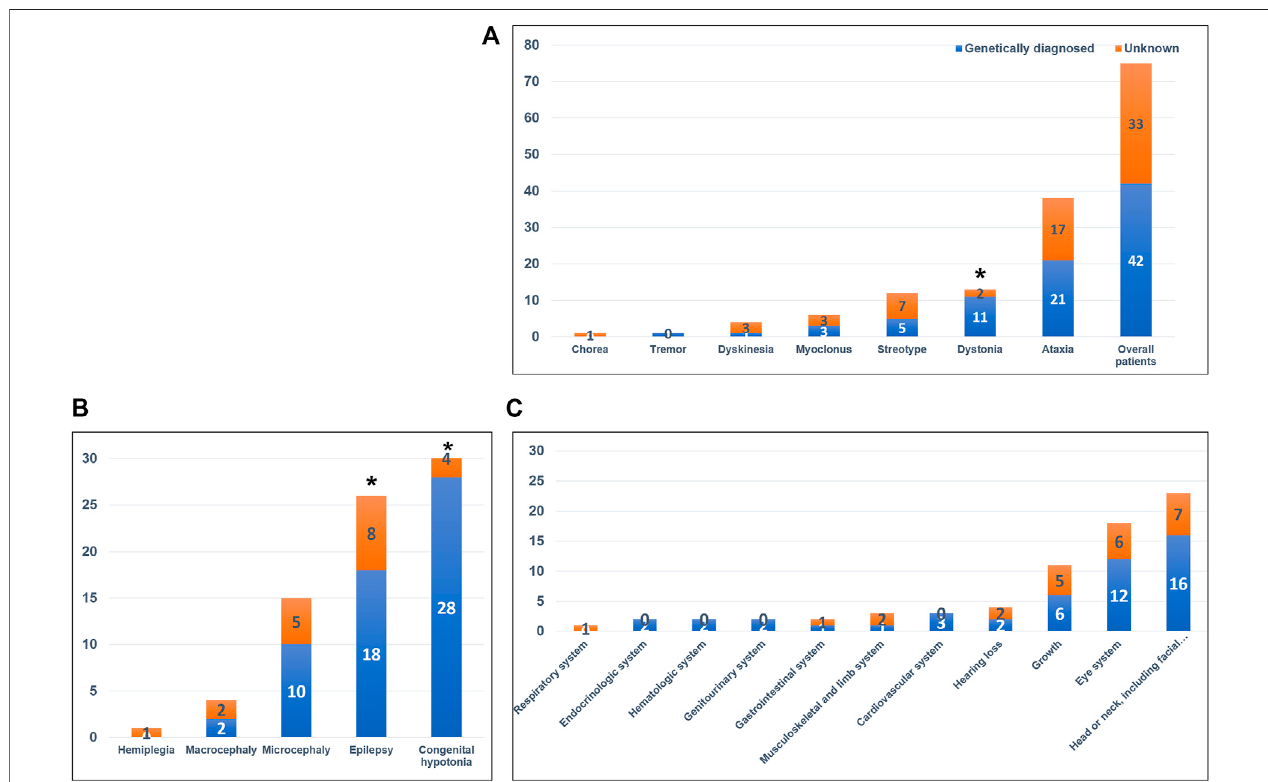
FIGURE 2| Diagnostic yield of whole-exome sequencing and associated neurologic and systemicsymptoms. (A) Diagnostic yield in the overall patient cohort and in the different movement disorders. Patients with dystonia had a signi fi cantly higher rate of genetic diagnosis compared with patients with other movement disorders ( p = 0.034 ). (B) Associated neurologic symptoms in the overall patient cohort. Patients with congenital hypotonia ( p < 0.001 ) and epilepsy ( p = 0.017 ) had a signi fi cantly higher rate of genetic diagnosis. (C) Associated systemic symptoms in the overall patient cohort. * p-value < 0.05